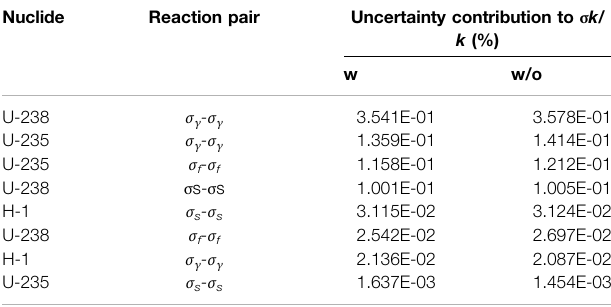
TABLE 4 | Implicit effect on uncertainty contributions.